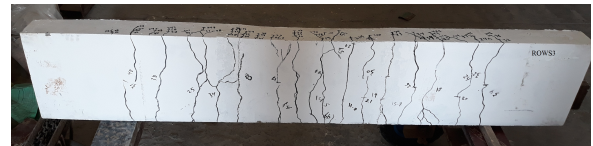
Figure 16: Bottom crack pattern of slab ROWS3.